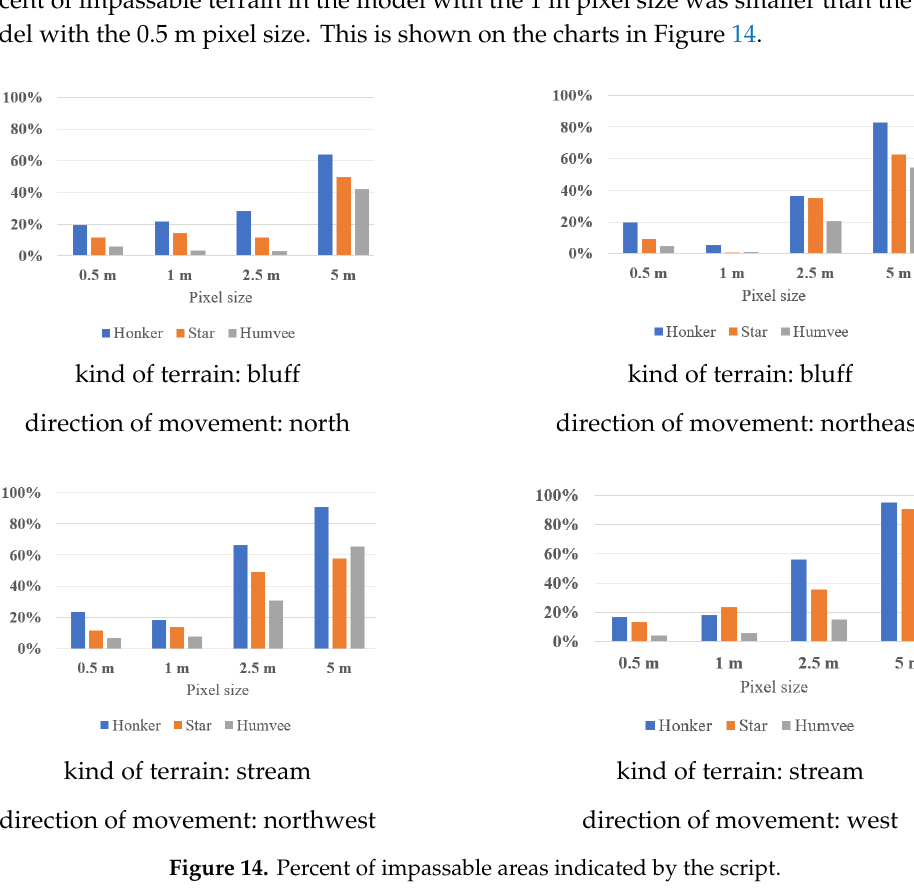
Figure 16. Illustrative figure of the intersection analysis. Due to the large number of outputs, the discussion will concern only the results for the Honker vehicle moving northward. The values of the intersection are presented in Tables 6–11, as explained in Figure 17. Figure 17. Interpretation of the record of results.